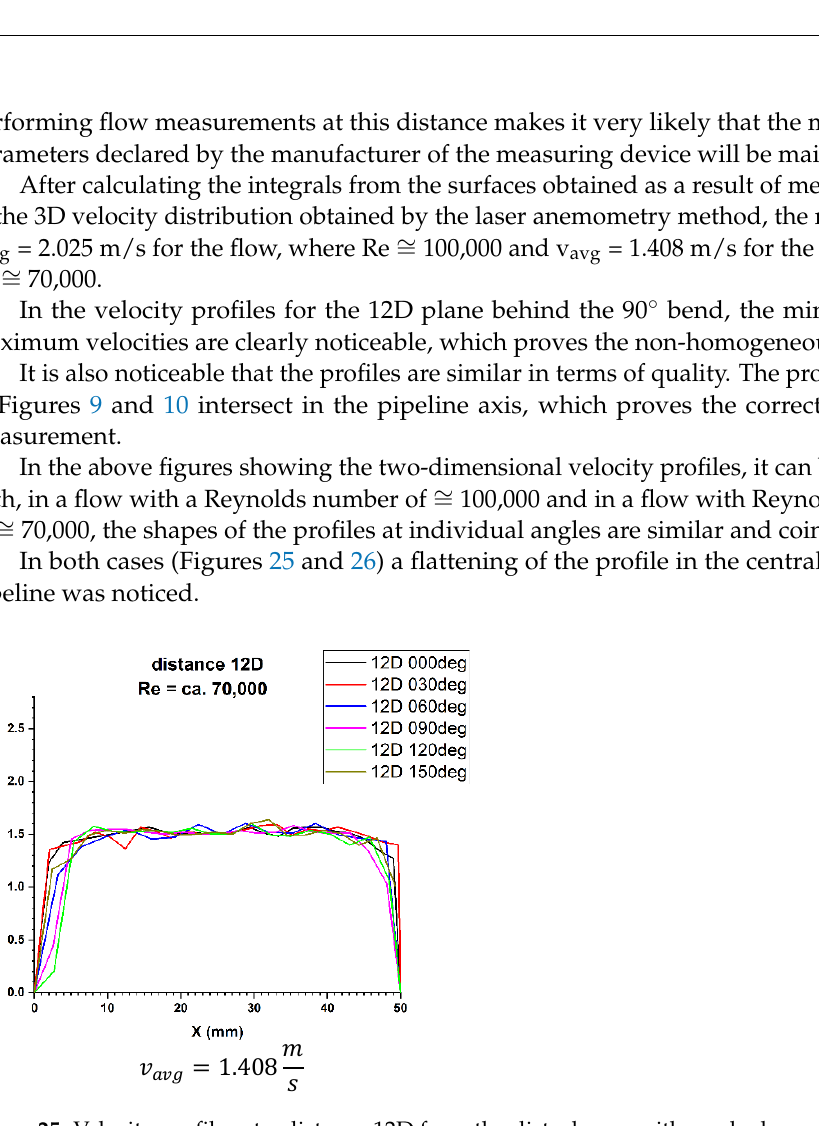
𝑚 𝑣 = 2.025 𝑎𝑣𝑔 𝑠